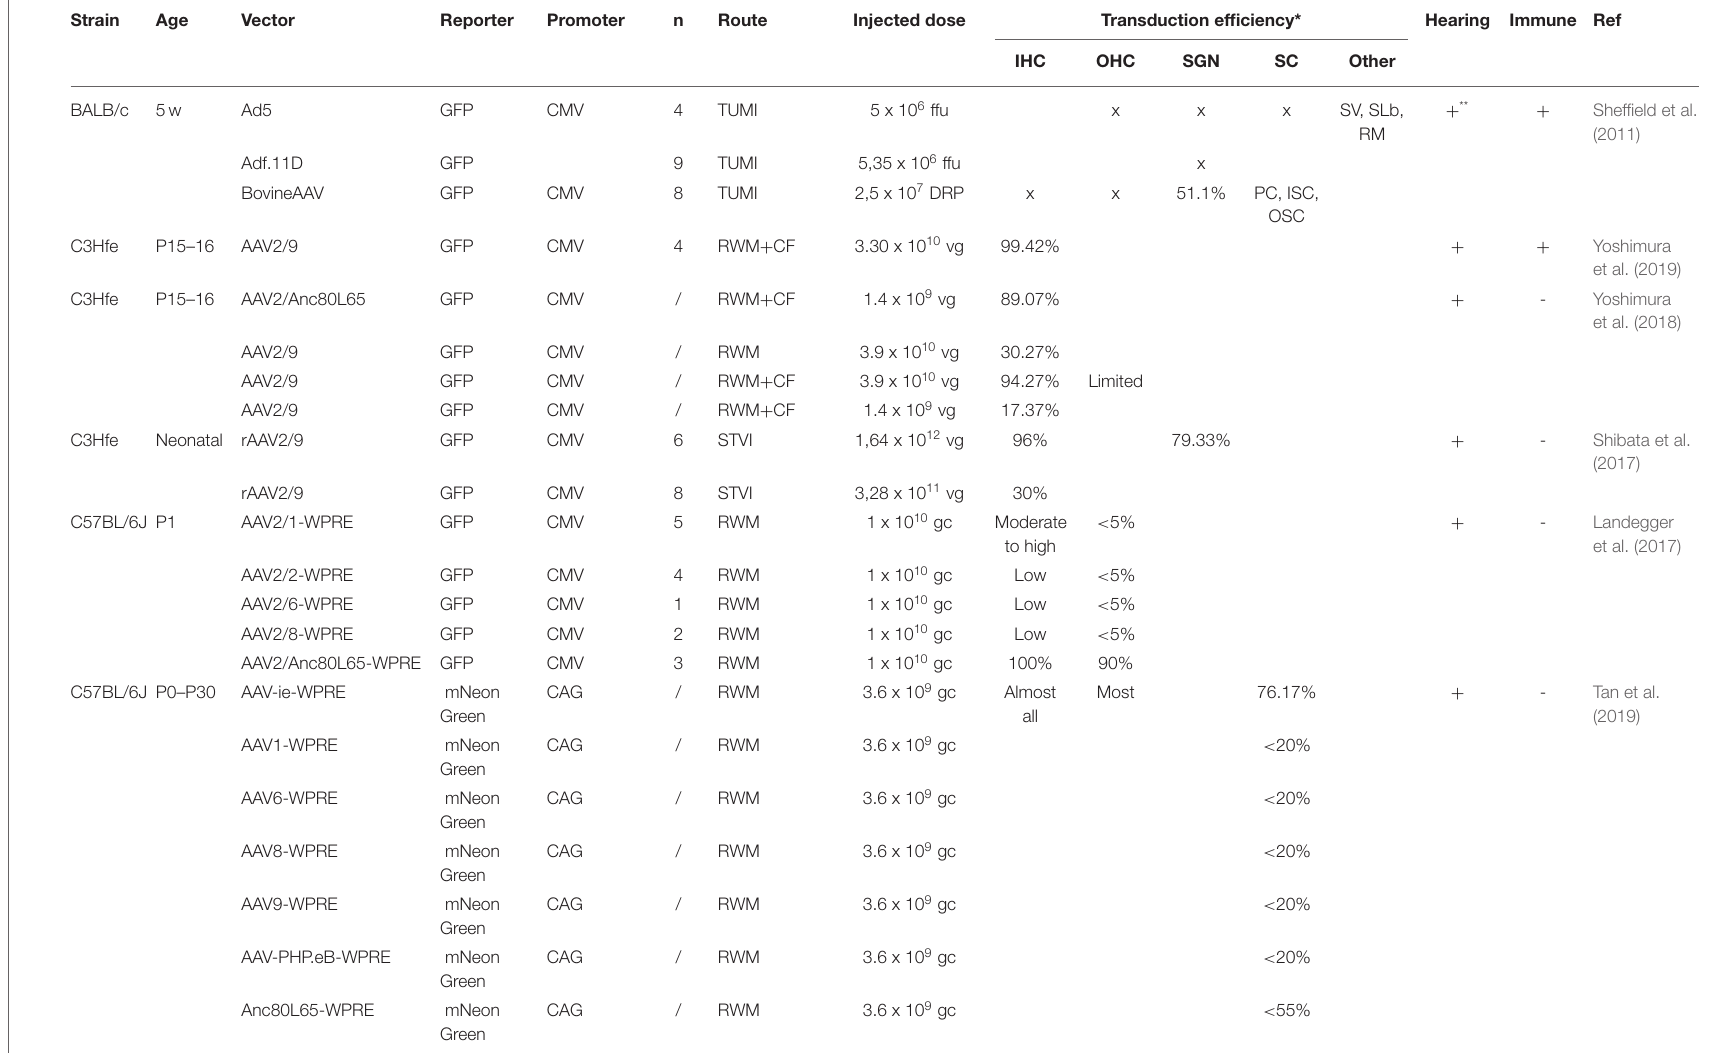
TABLE 1 | Summary of extracted data from gene therapy studies performed in mice.